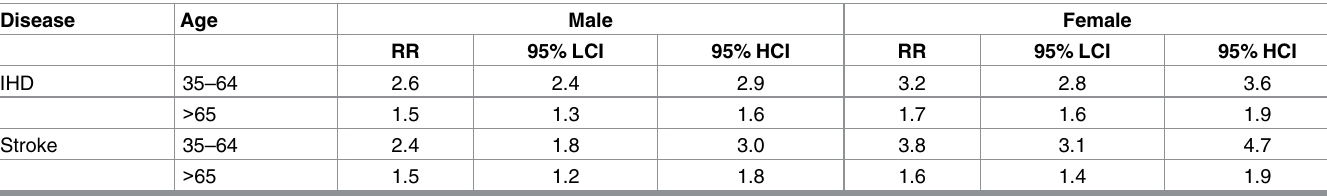
Table 3. Annual risk of IHD and stroke among smokerscompared to non-smokers.